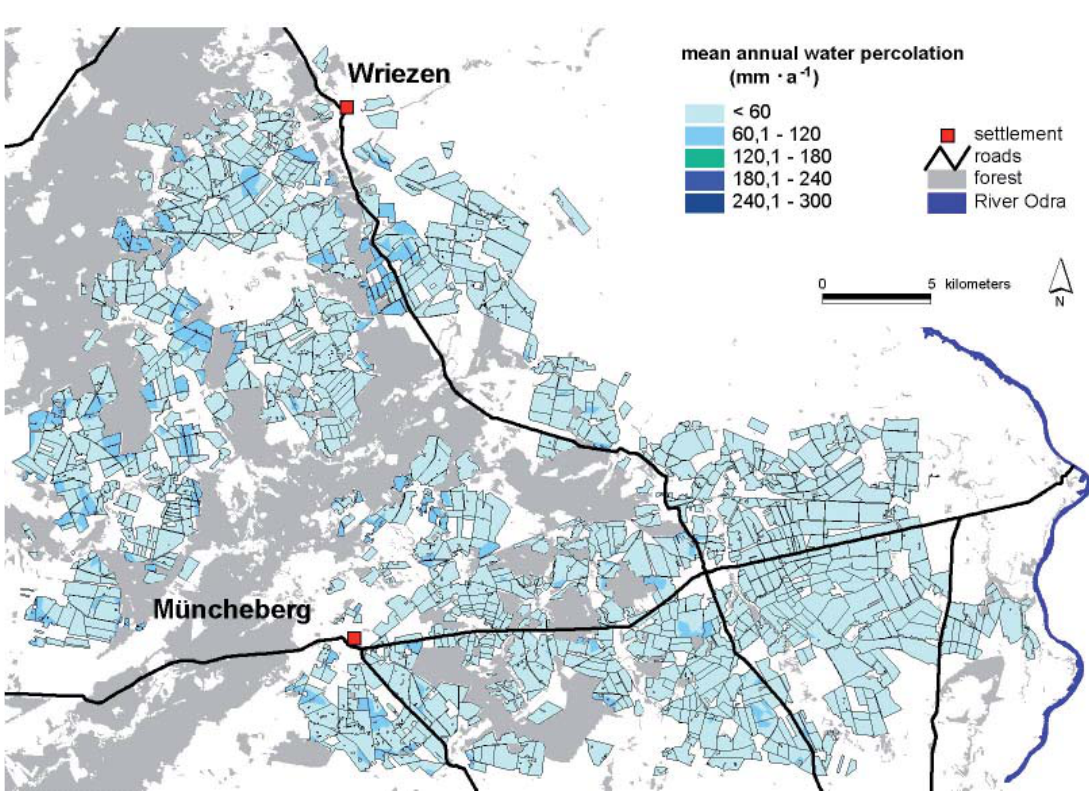
Figure 11. Mean annual water percolation of